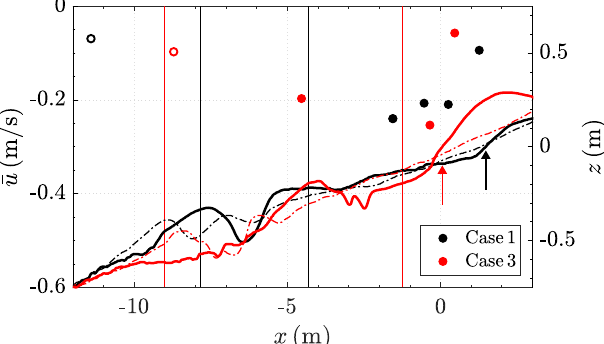
Figure 8. Time-averaged near-bed flow velocities ¯ u during first run of cases1 and 3 (left ordinate). Velocites were measured at 3cm above the initial bed (solid circles), except for the most offshore velocites which were measured at 8cm and 10cm in cases1 and 3, respectively (hollow circles). Right ordinate: pre- and post-run profile measurement as solid and dashed-dotted lines, respectively. Vertical lines indicate the breaking zone during the first run. Arrows indicate the shoreline location of the initial